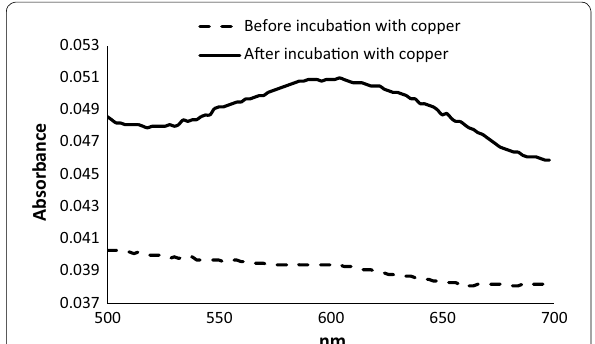
Fig. 2 Visible spectra of Sc Lac before ( dashed line ) and after ( solid line ) incubation with 0.5 mM CuSO 4 . We used 1 µM of recombinant enzyme to record the visible spectra between 500 and 700 nm